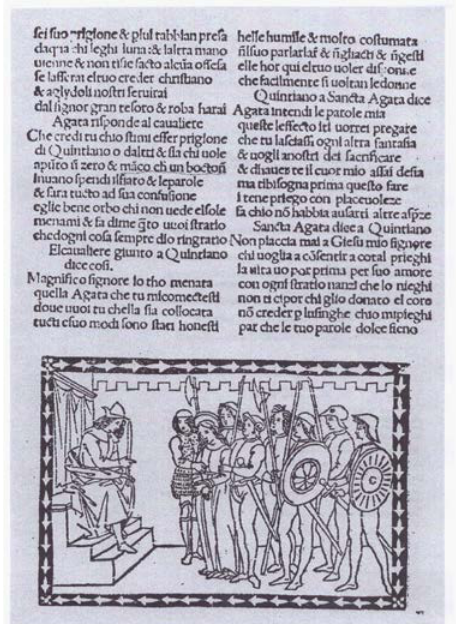
Figure 22 – La Rapresentatione di Sancta Agata Vergine & Martyre , ad instantia di ser Piero Pacini da Pescia, s.l.a. [but Firenze, Bartolomeo de’ Libri, around 1496?], f. a2v (BNCF, Banco Rari 179.8). By permission of Ministero per i beni e le attività culturali / Biblioteca Nazionale Centrale. Firenze